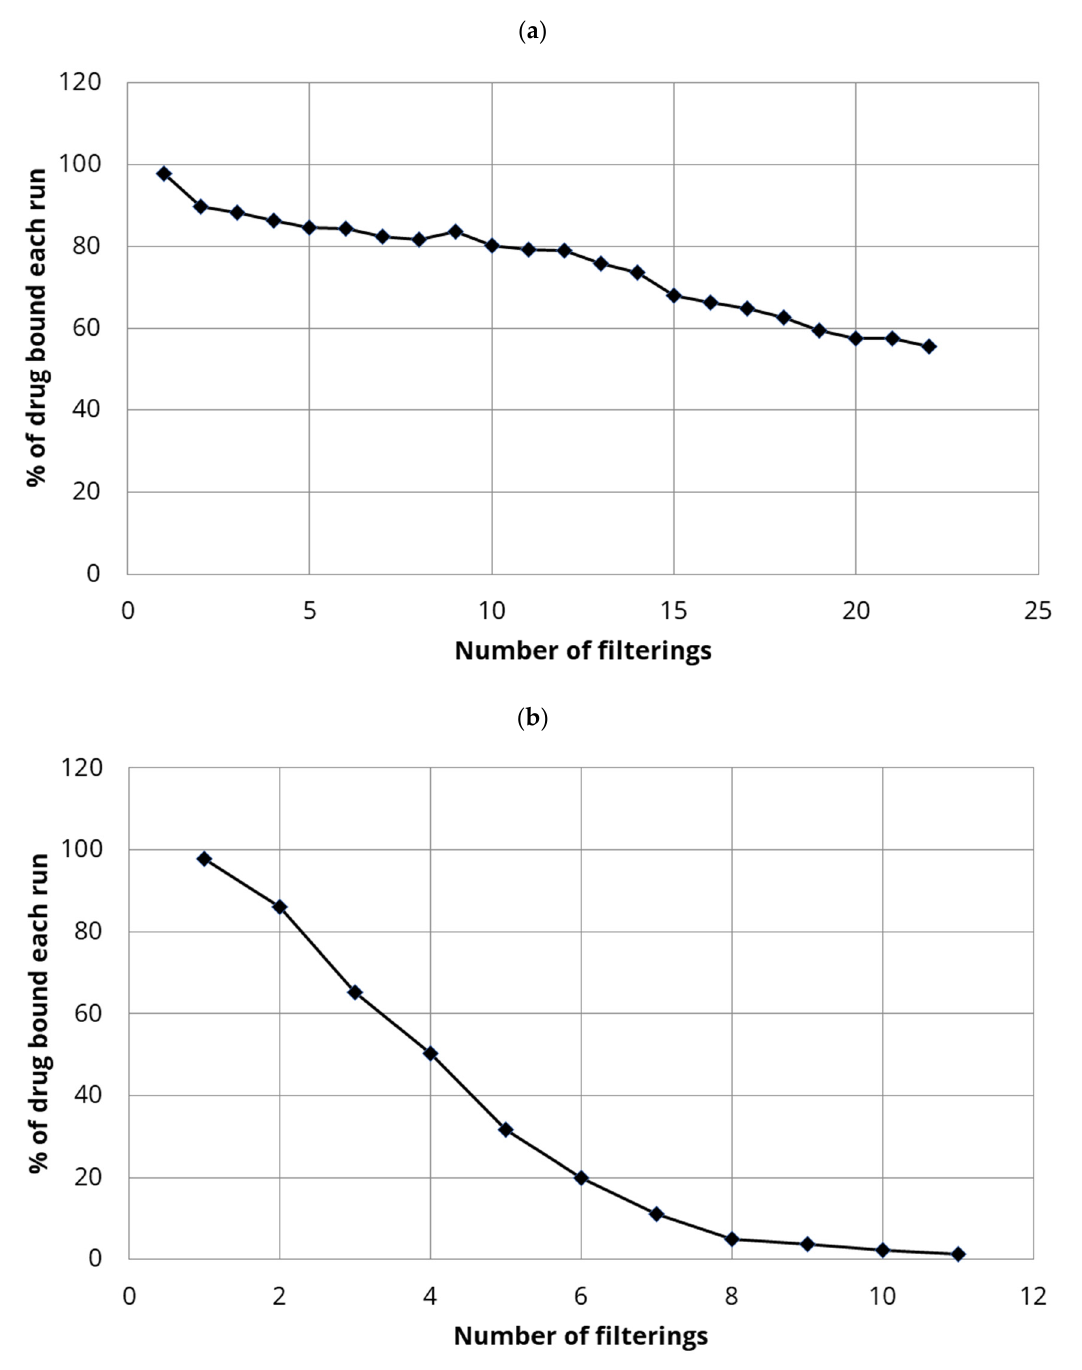
Figure 4. ( a ). Binding of estradiol (repeated 1 mL of 2 µg/mL) to hydrophobic CNC (CTAB-CNC) (25 mg of CTAB-CNC integrated into small-scale filter). ( b ). Binding of estradiol (repeated 5 mL of 2 µg/mL) to CTAB-CNC (5 mg of CTAB-CNC integrated into small-scale filter).